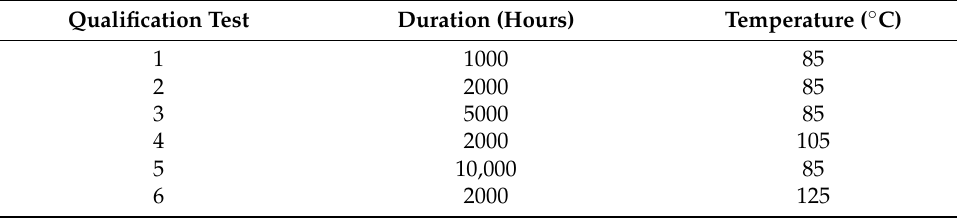
Table 2. Qualification test condition according to capacitor